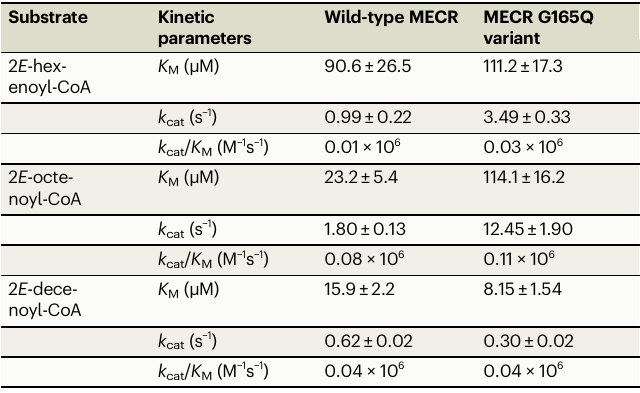
Table 1 | Kinetic parameters of wild-type MECR and the MECR G165Q variant Substrate Kinetic